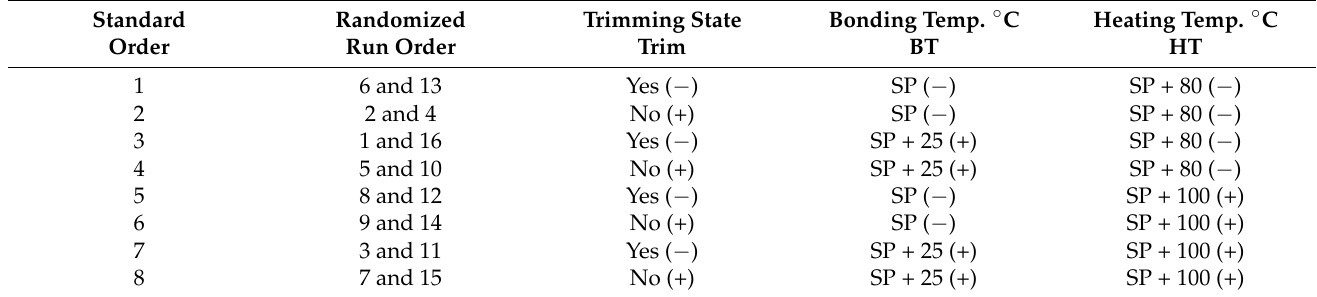
Table 2. A two-level three-factor factorial design with two